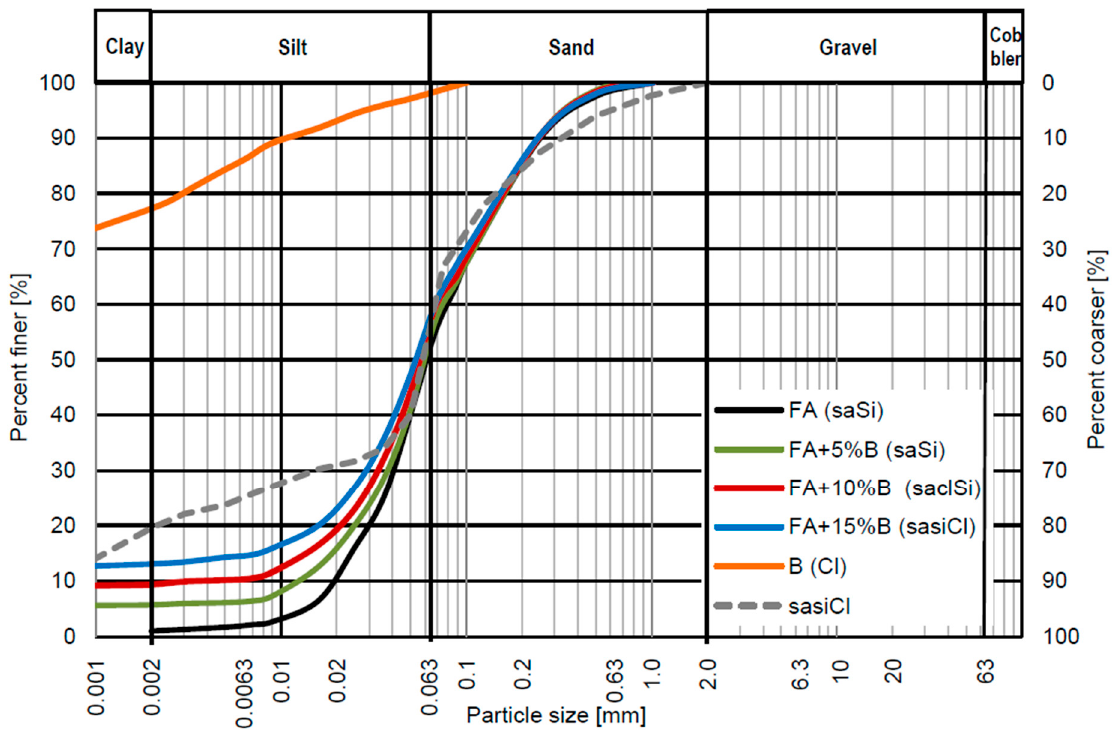
Figure 1. Grain size distribution curves of tested materials.